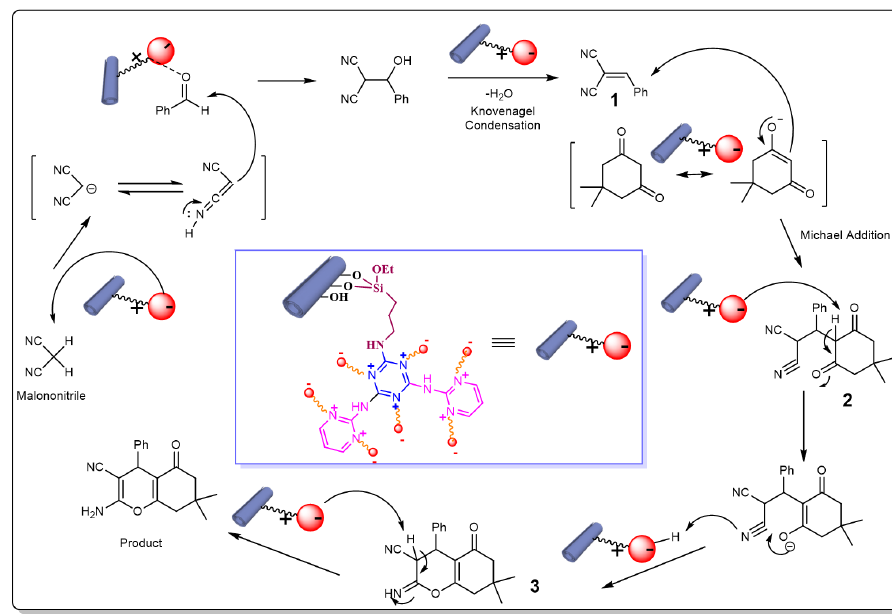
Figure 10. Plausible mechanism of preparation of 4 H -benzo[ b ] pyrans under Hal-Py-IL catalysis.